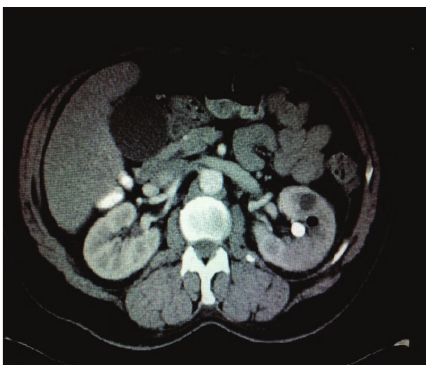
Figure 4: CT scan of the abdomen and pelvis showing left renal calculi with foci or air in the renal parenchyma.